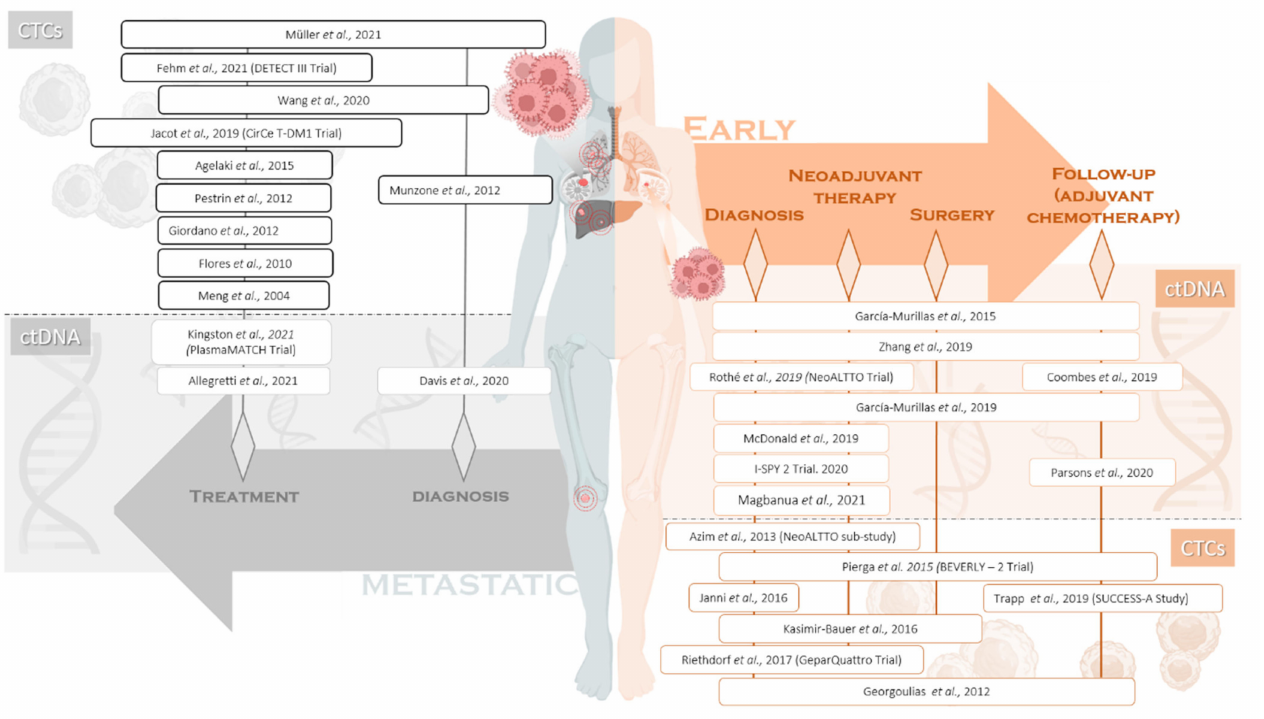
Figure 1. Schema depicting the reviewed studies and their focus on disease presentation and treatment stage. At clinical presentation, breast cancer (BC) patients can be divided into early (right part) and metastatic (left part) BC patients. The disease settings in patients’ clinical management are specified within the arrows. The studies included in this review are shown based on the investigated treatment stage as well as the employed liquid biopsy analyte. CTCs, circulating tumour cells; ctDNA, circulating tumour